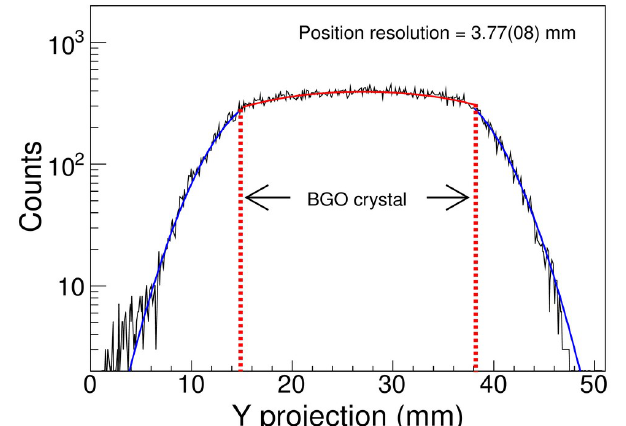
Fig. 9: Y-projection of a slice (X = 22.5 to 27.5 mm) of the experimentally reconstructed BGO image in figure 8(B) showing the variation of the absorbed gamma-ray counts throughout the BGO crystal.